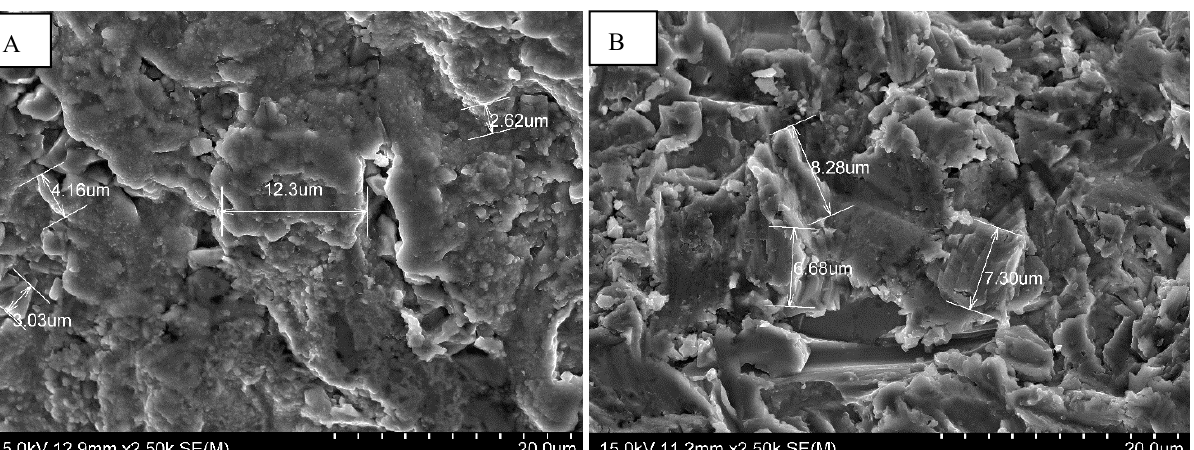
Figure 3. SEM images of the Axiom ® implant surface morphology from Anthogyr ( A ); Natea ® from Euroteknika ( B ) and Idcam ® IDI System ( C ) showing irengular surfaces: magnification ×300.